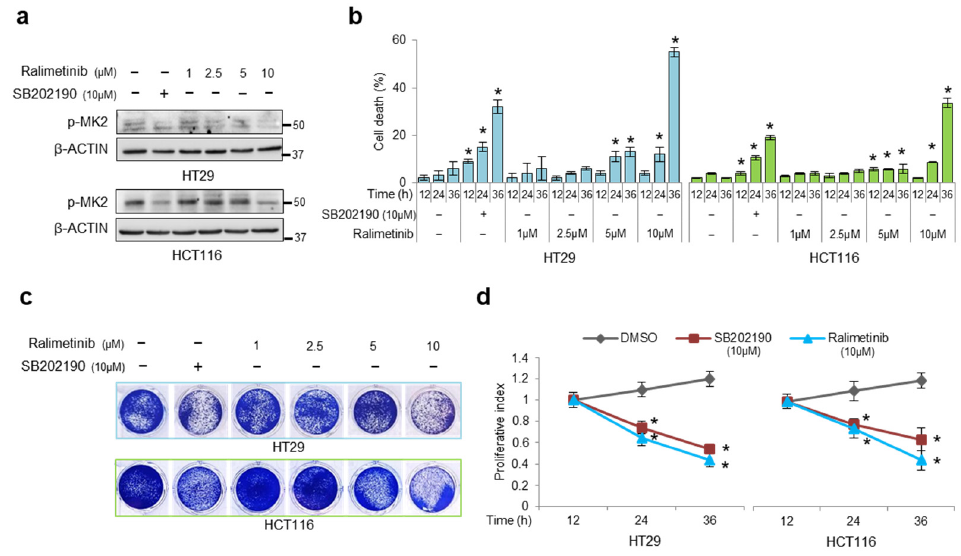
Figure 3. Treatment of CRC cells with ralimetinib or SB202190 decreases viability while increasing cell death. ( a ) Immunoblotting showing phosphorylated MK2 protein levels in HT29 and HCT116 cells treated with SB202190 (10 µ M) or ralimetinib (1–10 µ M) for 24 h. β -actin was used as a loading control. ( b ) Quantification of cell death by trypan blue staining in HT29 and HCT116 cells treated with SB202190 (10 µM) or ralimetinib (1–10 µM) for up to 36 h. ( c ) Cell viability assay on HT29 and HCT116 cells treated with ralimetinib (1–10 µM) or SB202190 (10 µM) for 36 h. (d) Proliferative index of HT29 and HCT116 cells treated with ralimetinib (10 µM) or SB202190 (10 µM) for up to 36